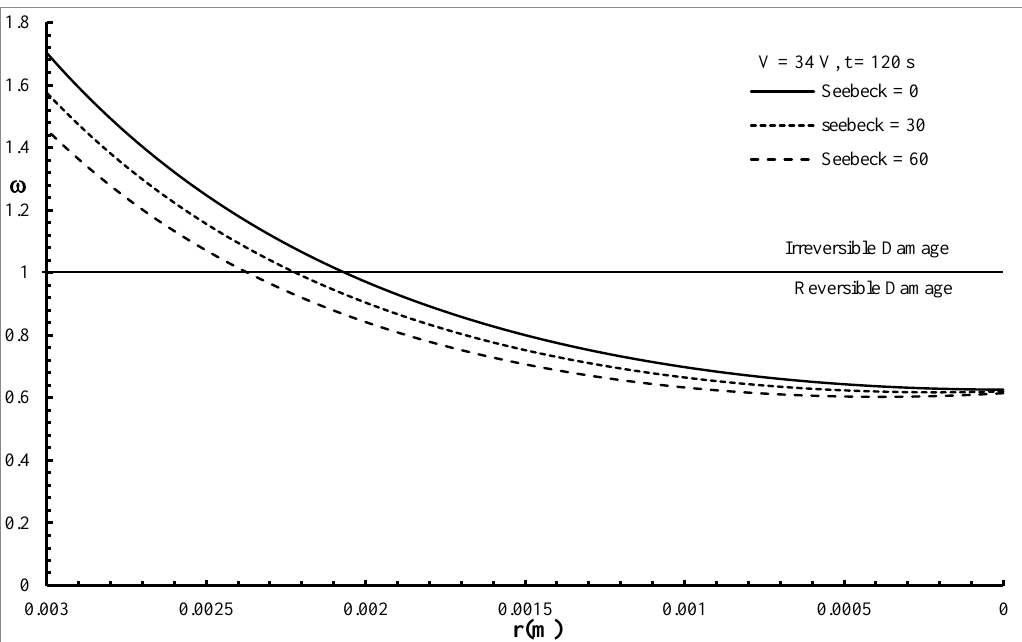
Figure 18. The thermal damage distribution of liposarcoma tumor with various values of the Seebeck coefficient when 600 e R   .